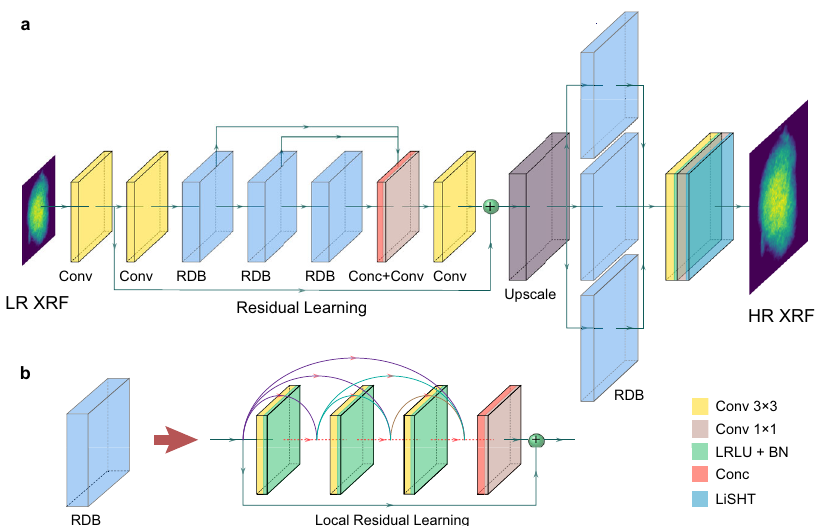
Fig. 2 Architecture of our proposed residual dense network (RDN) for super-resolution X-ray fl uorescence image reconstruction. a Overall layout of the ML model. b Detailed layout of residual dense block. For these RDBs, the input and output of each layer are fed into other layers as inputs. The curved lines show the feeding operations. Here, Conv represents the convolutional operation, and Conc refers to the concatenation of the feature map.